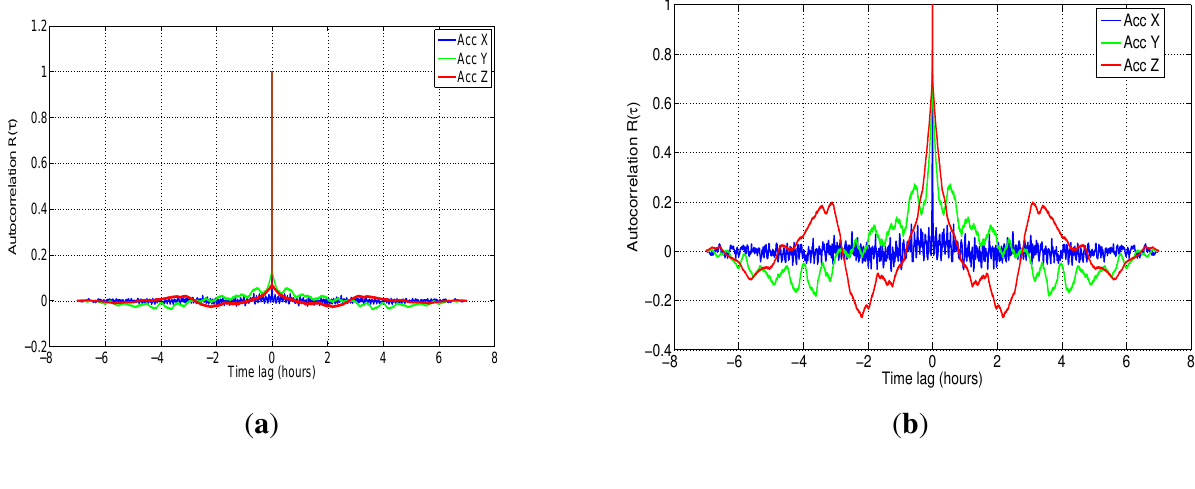
Figure 11. ( a ) IMU 3DM-GX3-25 autocorrelation for gyros; ( b ) IMU 3DM-GX3-25 autocorrelation for gyros after applying wavelet de-noising with six